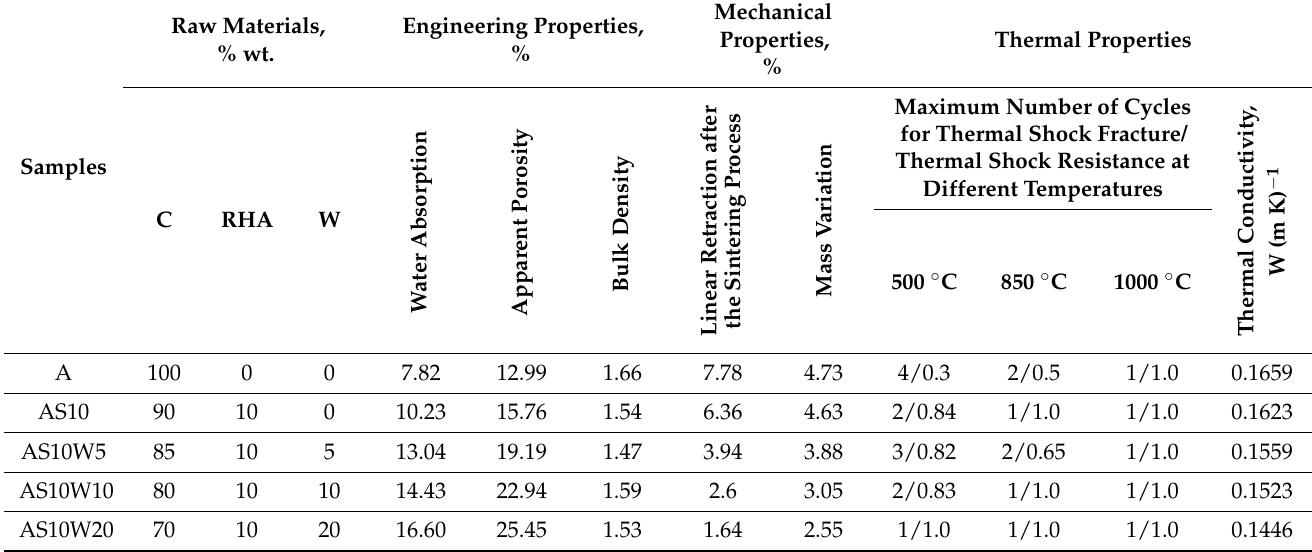
Table 2. Composition and properties of A/S/W-based refractory. Data from